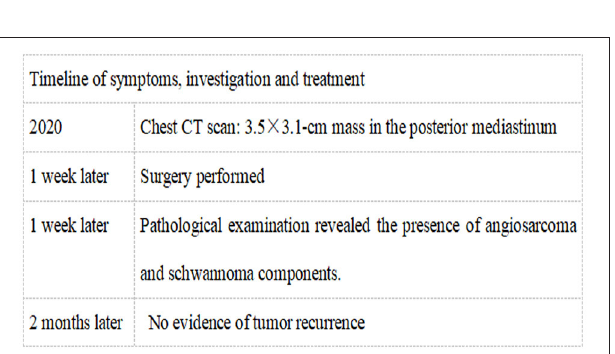
FIGURE 4 | Timeline of symptoms, investigation, and